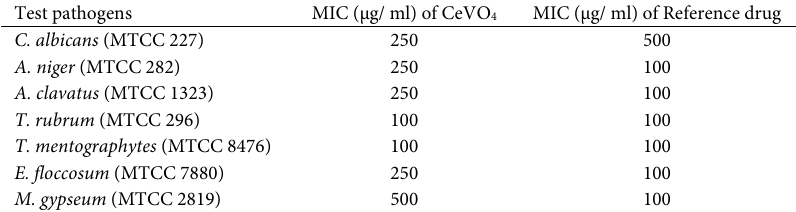
NPs Table 1. Minimum inhibition concentration of CeVO 4 4 NPs against fungal pathogens NPs against fungal 4